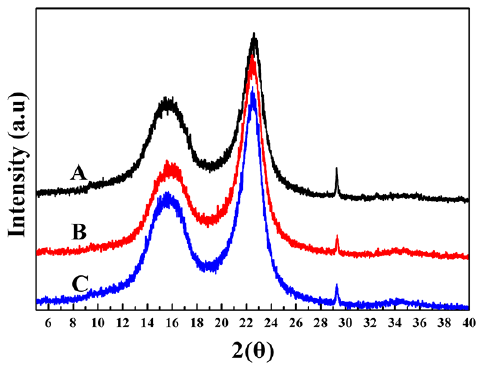
Figure 3. XRD analysis of oxygen-delignificated kraft pulps with or without IL pretreatments: (A) control pulp, (B) [BMIM][HSO 4 ] pretreated pulp, and (C) [TEA][HSO 4 ] pretreated pulp.